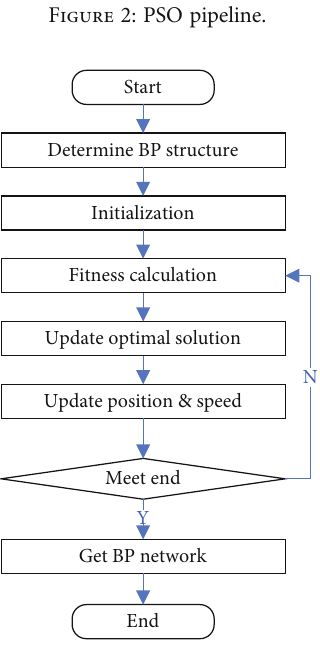
Figure 2: PSO pipeline.